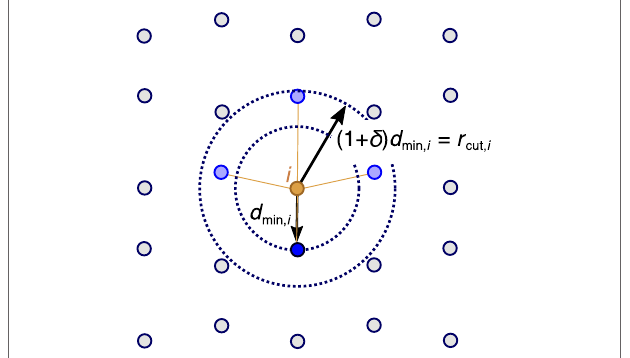
FIGURE 2 | Atoms that are bonded (blue spheres) to a given central site i (orange) are identified on the basis of the nearest-neighbor distance, d min, i (absolute or dimensionless) and an a priori chosen tolerance, δ , thus, defining a site-specific cutoff radius r cut, i = (1 + δ ) d min, i .